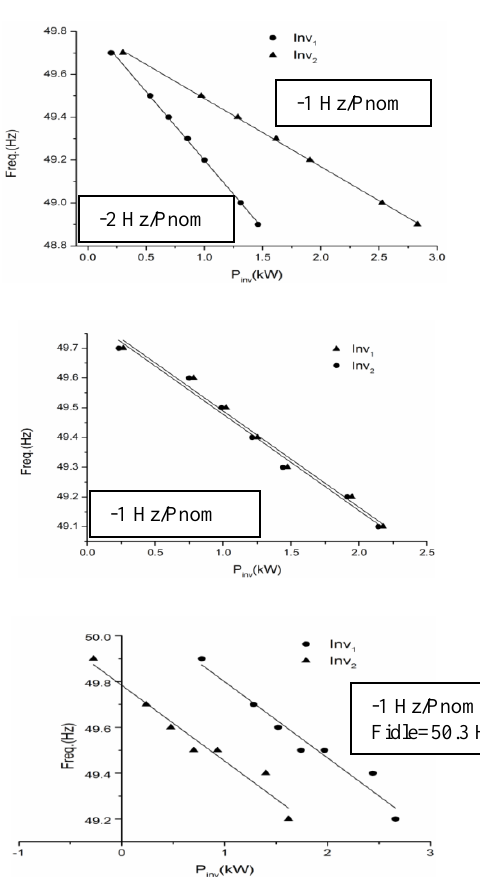
Figure 16. Load sharing for parallel operation of two Inverters.